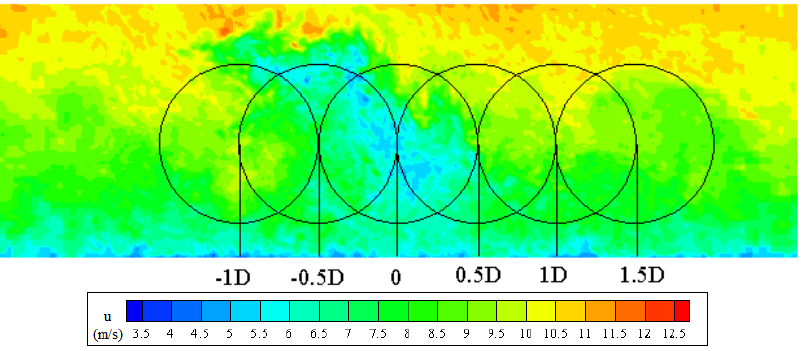
Figure 5. Various turbine positions −1D, −0.5D, 0, 0.5D, 1.0D, and 1.5D, and the instantaneous streamwise velocity contour shown in the flow direction.